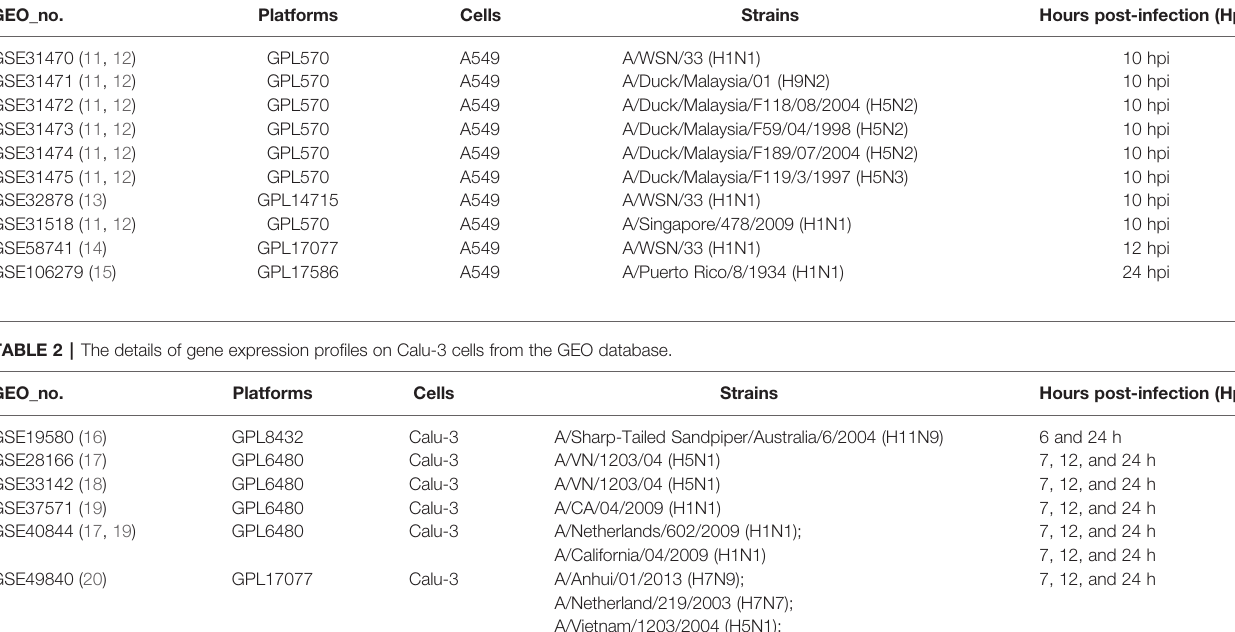
TABLE 1 | The details of gene expression pro fi les on A549 cells from the GEO database. GEO_no.